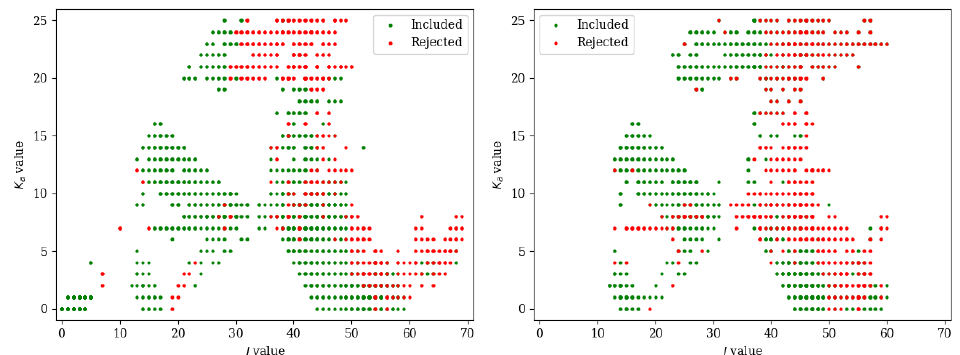
Figure 4. Graphical representation of the included and rejected transitions of the 0 + ( left panel) and 0 − ( right panel) states in the fitting